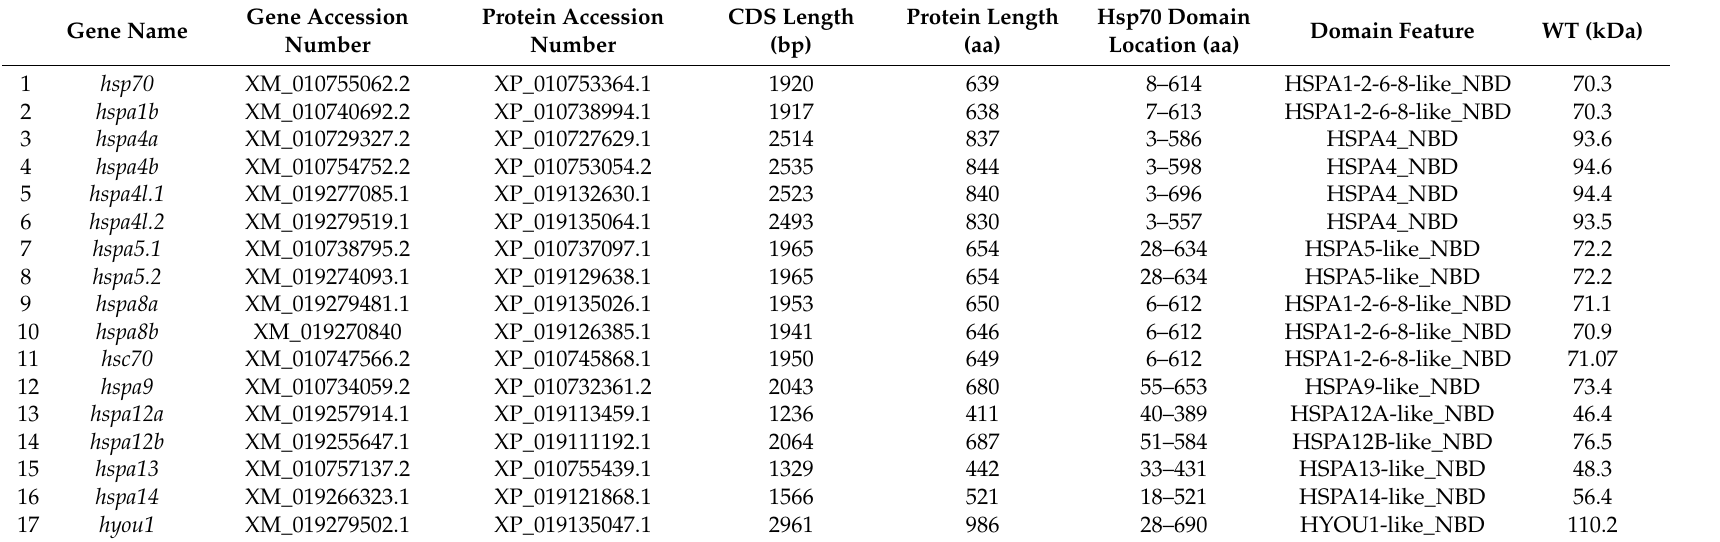
Table 1. Summary of 17 hsp70 genes identified in the large yellow croaker